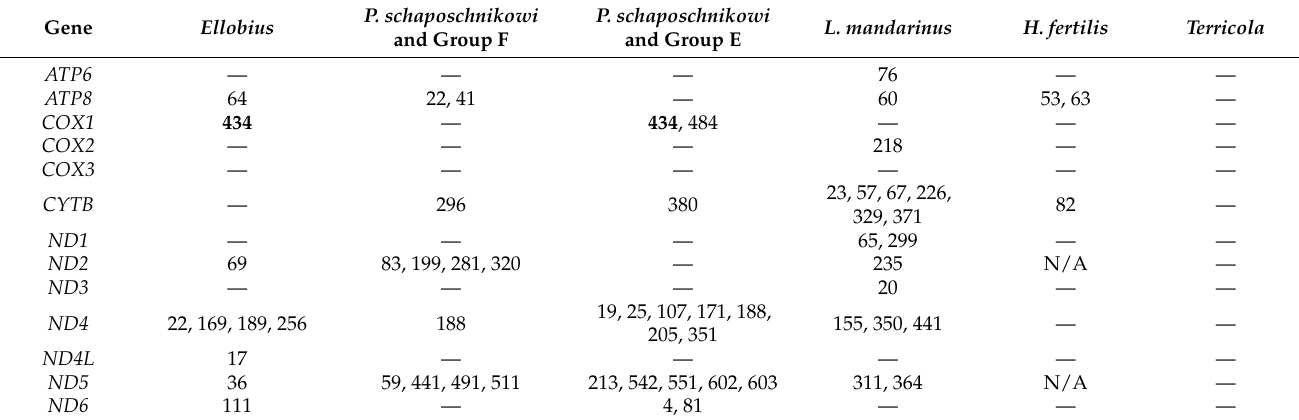
Table 4. Sites under positive selection found in mitochondrial genes using the MEME approach. N/A—not analyzed, “—”—analysis did not show sites under positive selection. Homologous site found for several species in COX1 indicated in